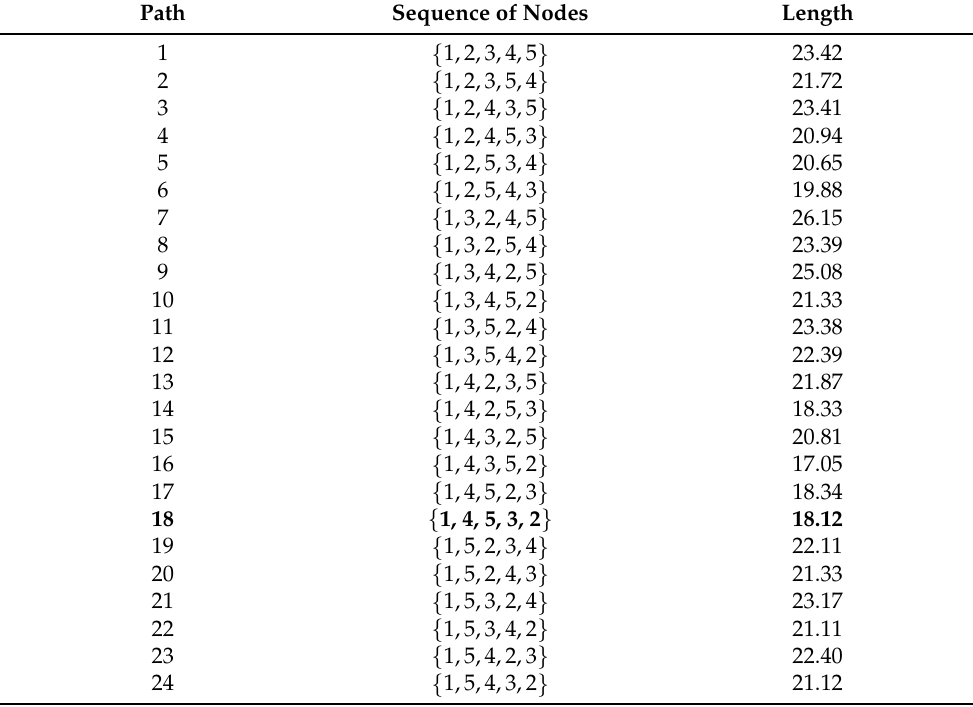
Table 9. Performance of the paths from Figure 3. Path Sequence of